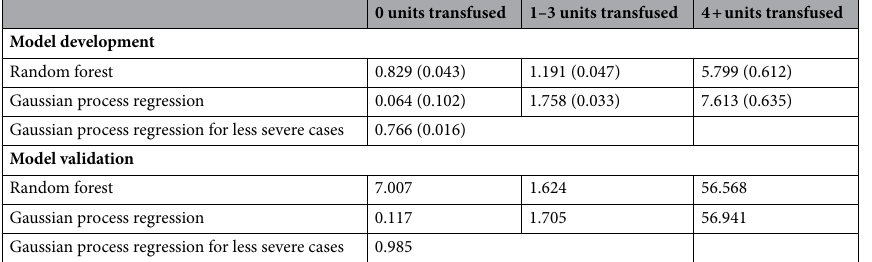
Table 3. Random Forest (RF) versus Gaussian process (GP) regression. This table shows our GP regression model compared with the RF regression model. GP regression performed best as demonstrated by the low root mean square error (RMSE) in the 0 units transfused and 1–3 units transfused categories. In contrast, performance of both models suffered when predicting 4 + RBCs transfused. Therefore, in the final model we restricted the GP regression prediction to cases where < 4 RBCs transfused was predicted by GP